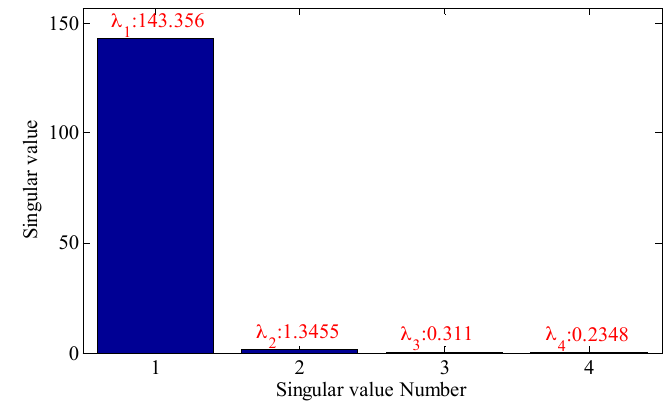
Figure 17. Singular value of trace matrix.